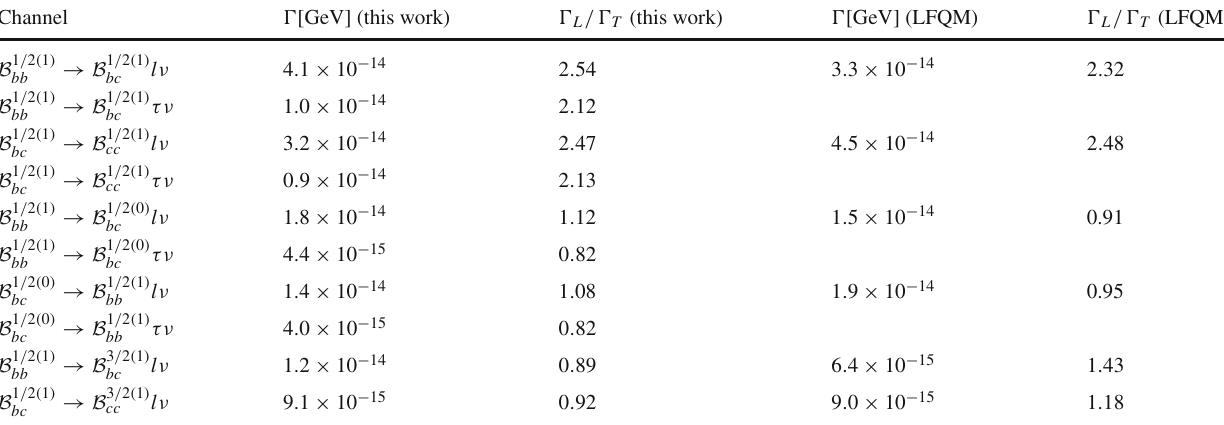
Table 1 Decay widths of B bb → B bc ( l /τ)ν . Comparison between the results in this work and those derived in Ref. [9] using the LFQM Channel